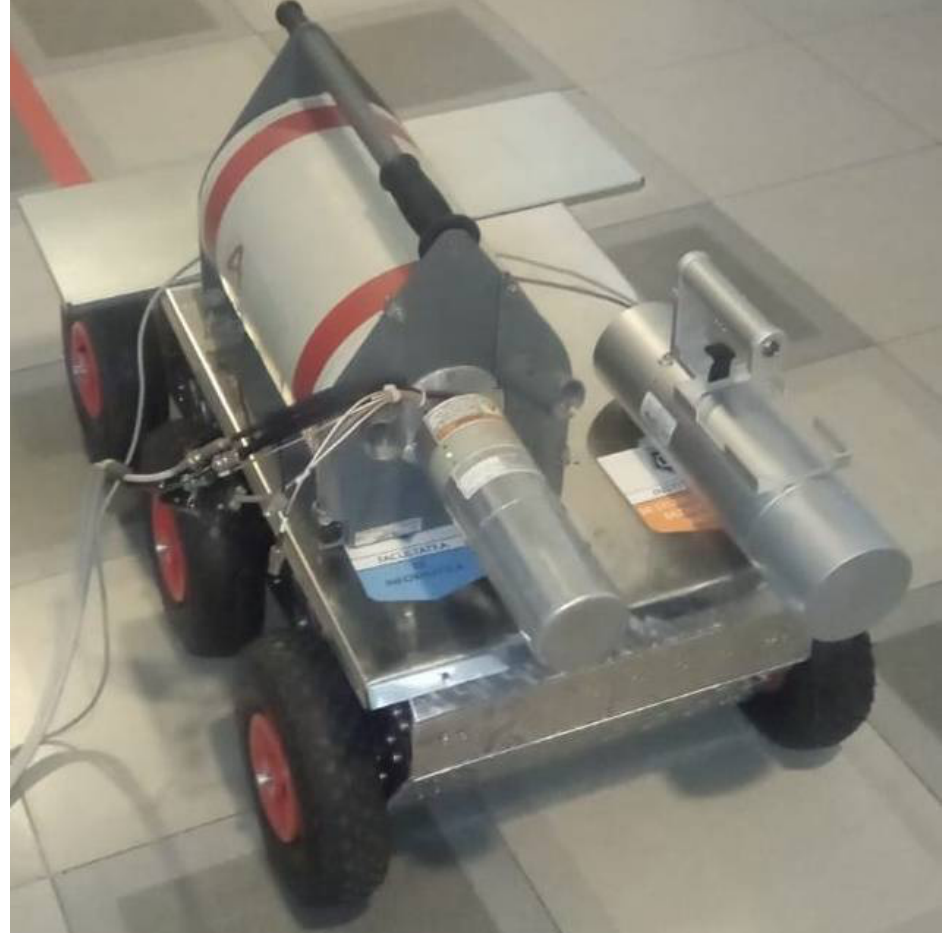
Figure 25. Robotic system with an operational vector used to determine gamma radiation. The experiments were recorded at Titu Maiorescu University in Bucharest.